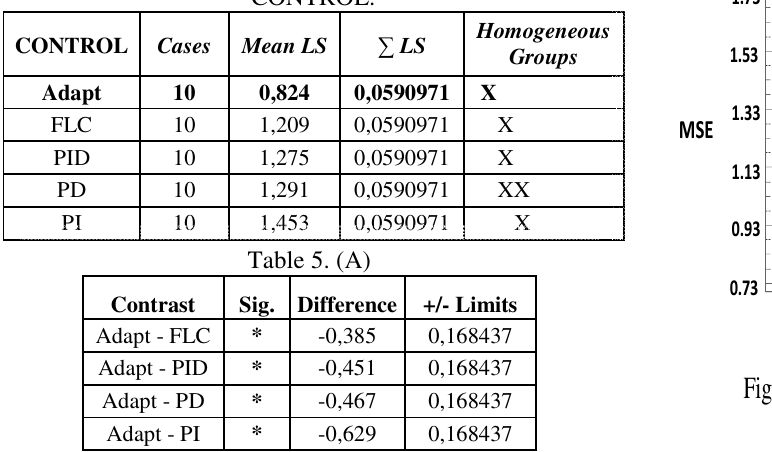
Table 4. (A) Method of 95,0% LSD for MSE of CONTROL.